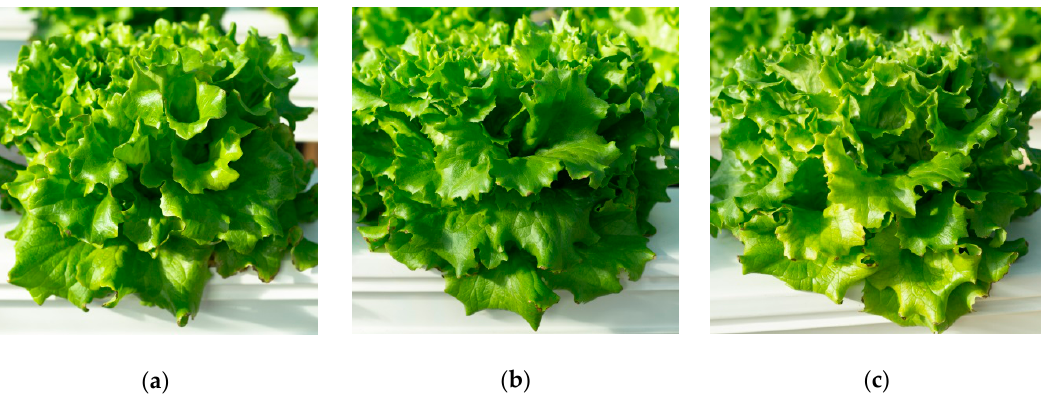
Figure A1. Close-up images of lettuce grown in ( a ) System AER, ( b ) System ANA, and ( c ) System RAS.